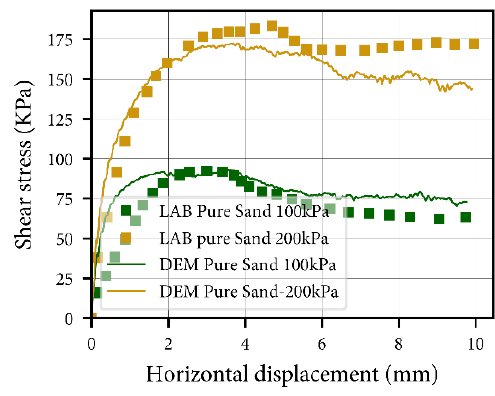
Figure 6. Comparisons of stress–strain responses of pure sand and FRS between experiment and DEM simulation.